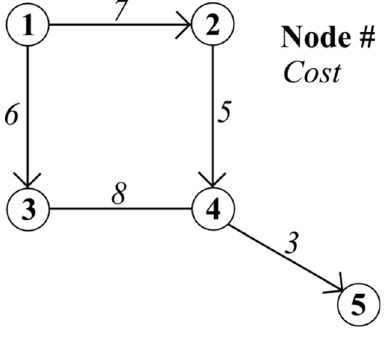
Figure 4. Graph example . Figure 4. Graph